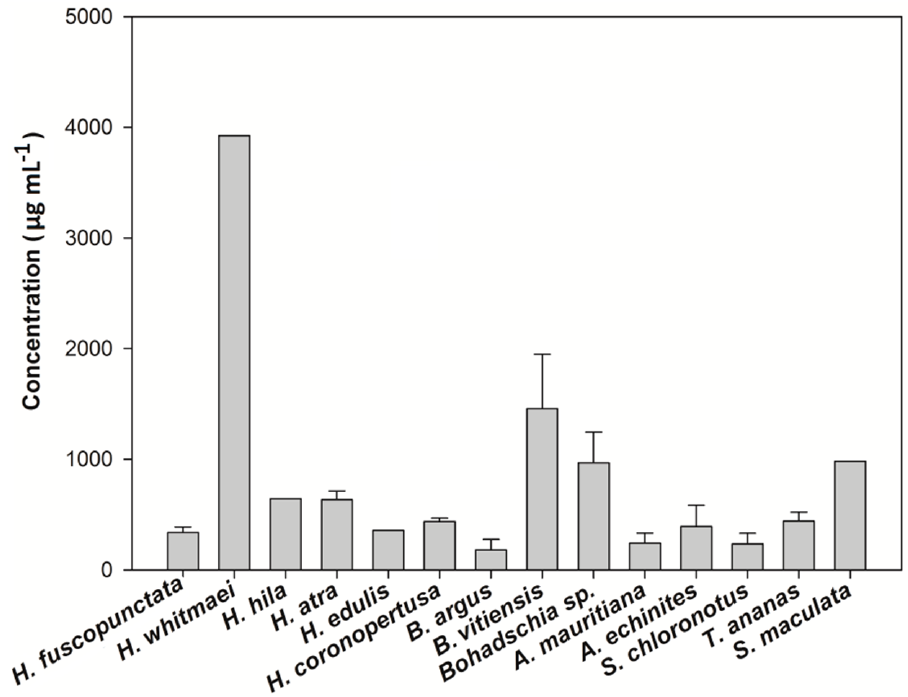
Figure 4. Calculated LC 50 concentrations from the brine shrimp mortality assay for the 14 different sea cucumber crude extracts after 48 h. Results express average values + standard error.